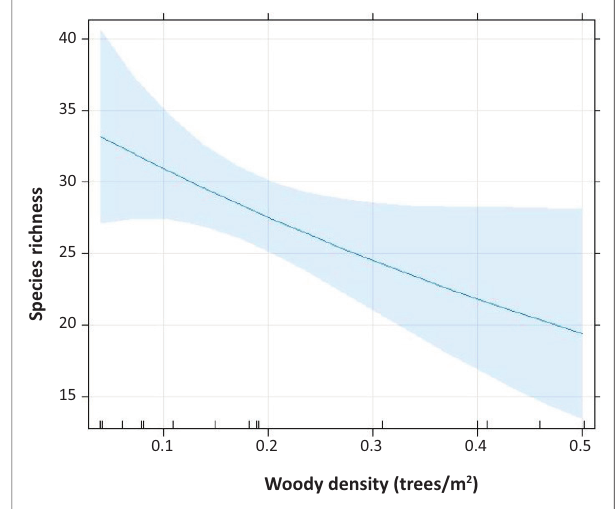
FIGURE 9-A1: Effects plot showing how avian species richness is affected by the density of woody vegetation above 0.5 meters in height. Light shaded blue represents the 95 % confidence interval for the fitted model.